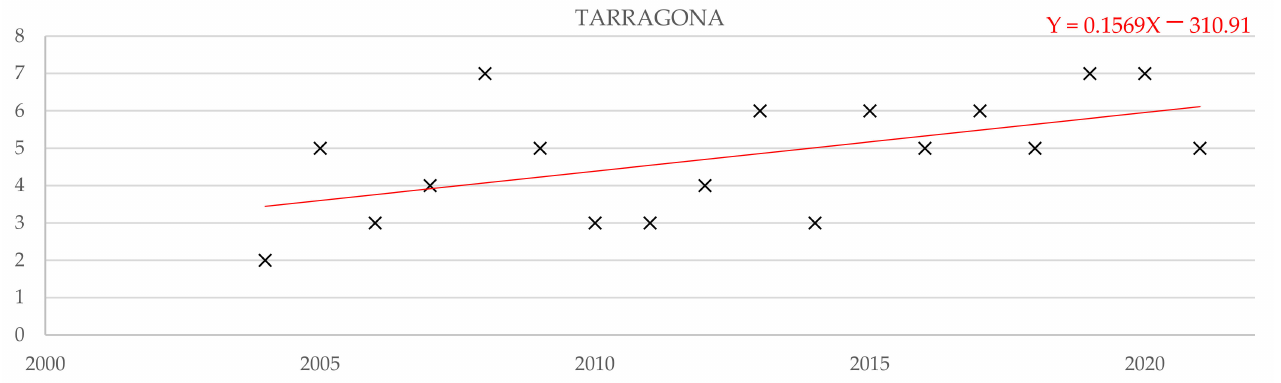
Figure 24. Number of times Hs has exceeded the threshold in Mahon.